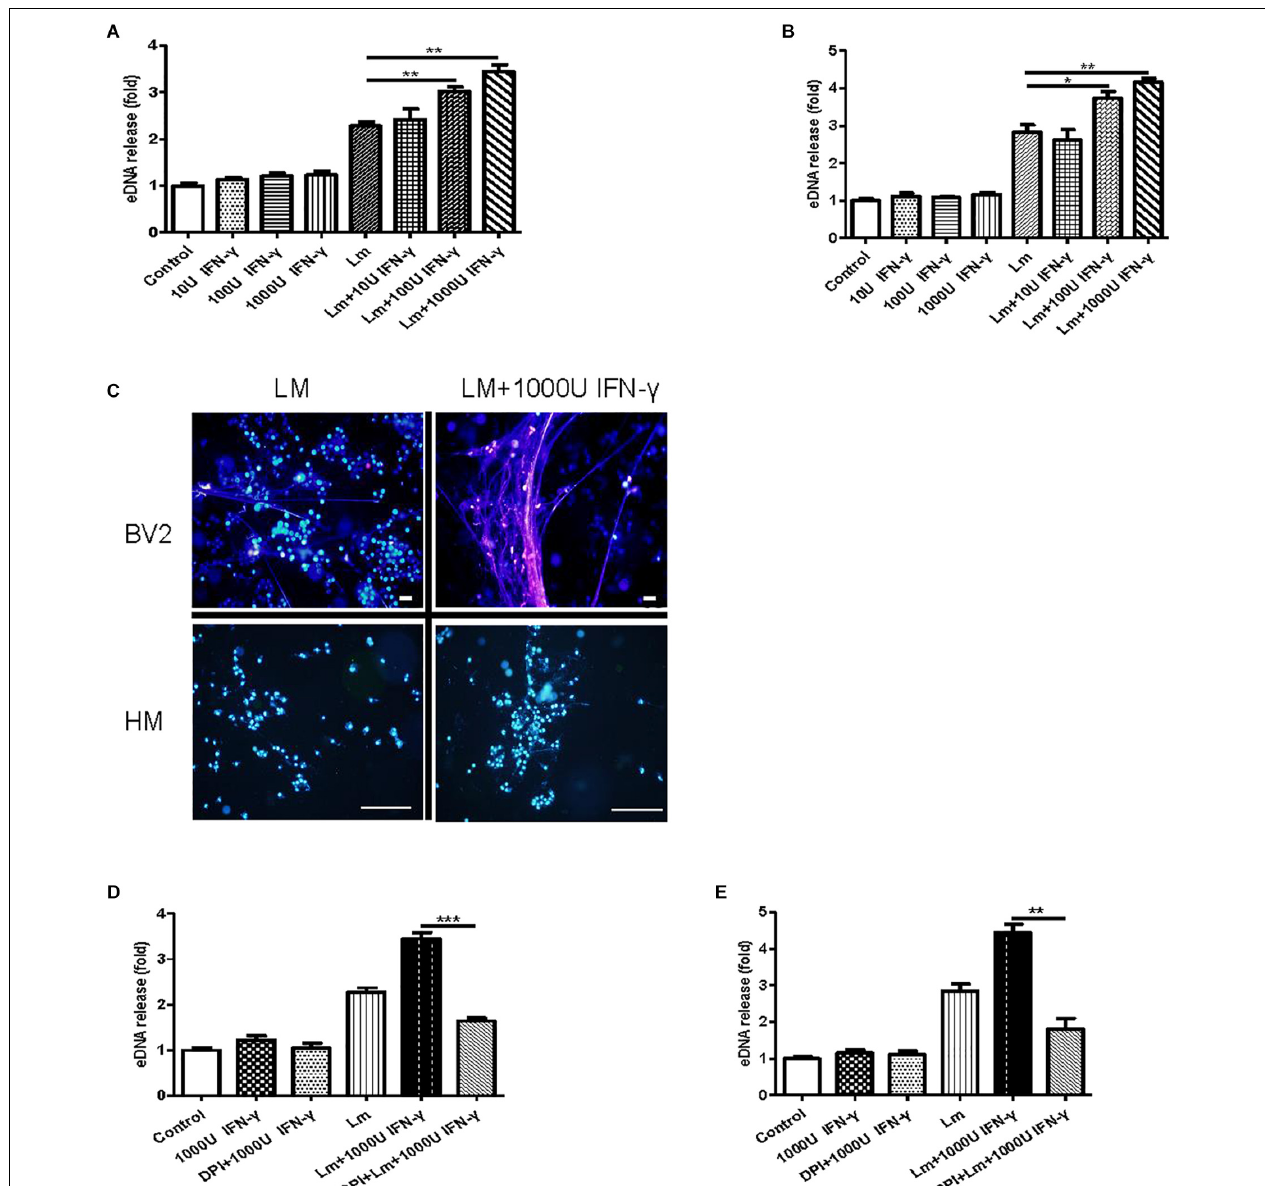
FIGURE 7 | The effect of interferon- γ on MiET production in vitro . Mouse or human microglia were incubated in 24-well flat bottom plates. BV2 cells were treated with diluted concentrations of IFN- γ , IFN- γ and Listeria; then, eDNA release was detected (A) . Human microglia were treated the same as described for BV2 cells (B) . eDNA staining was detected (C) . Scale bars = 50 µ m. BV2 cells were pre-treated with DPI (50 µ M) for 1 h and then treated with IFN- γ (1000 U), IFN- γ (1000 U) and Listeria for 2 h. A plate reader was used to quantify eDNA release (D) . Human microglia were conducted as described above for BV2 cells (E) . ∗ p < 0.05, ∗∗ p < 0.01, ∗∗∗ p < 0.001. The data are representative of triplicate experiments and presented as the mean value ± the